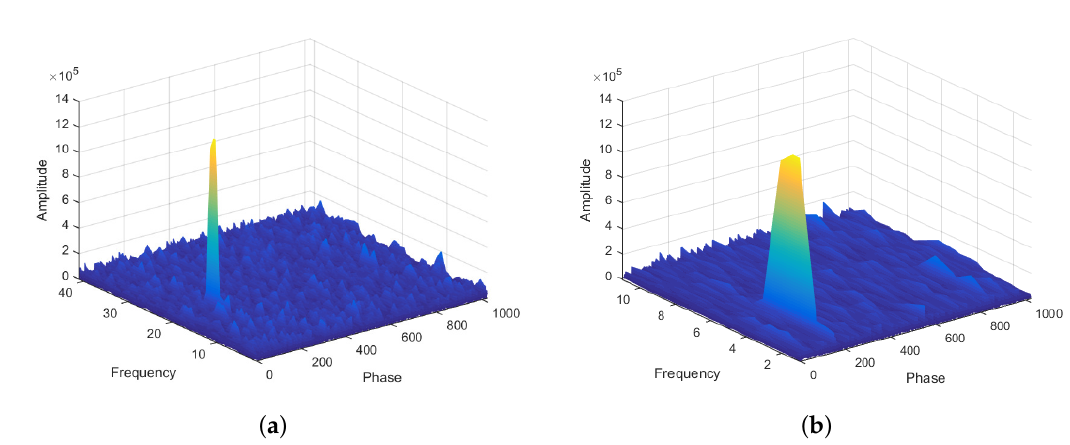
Figure 6. Illustration of the final result of a correlation matrix for a satellite search with ( a ) a fine frequency bin (500 Hz) and ( b ) a coarse frequency bin (2